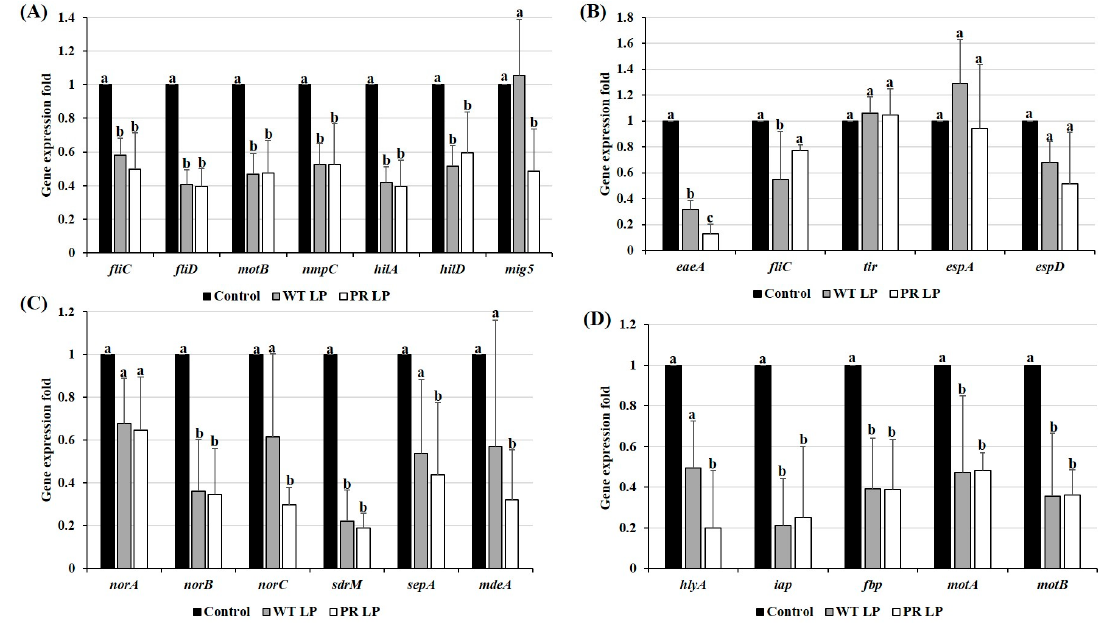
Figure 6. Relative expression of virulence genes of S. Typhimurium ( A ), EHEC ( B ), S. aureus ( C ), and L. monocytogenes ( D ) treated with CFCSs of wild-type LP and LP + PR strains. Error bars indicate standard deviation from 6 parallel trials. Different letters (a–c) are significantly different at P < 0.05.